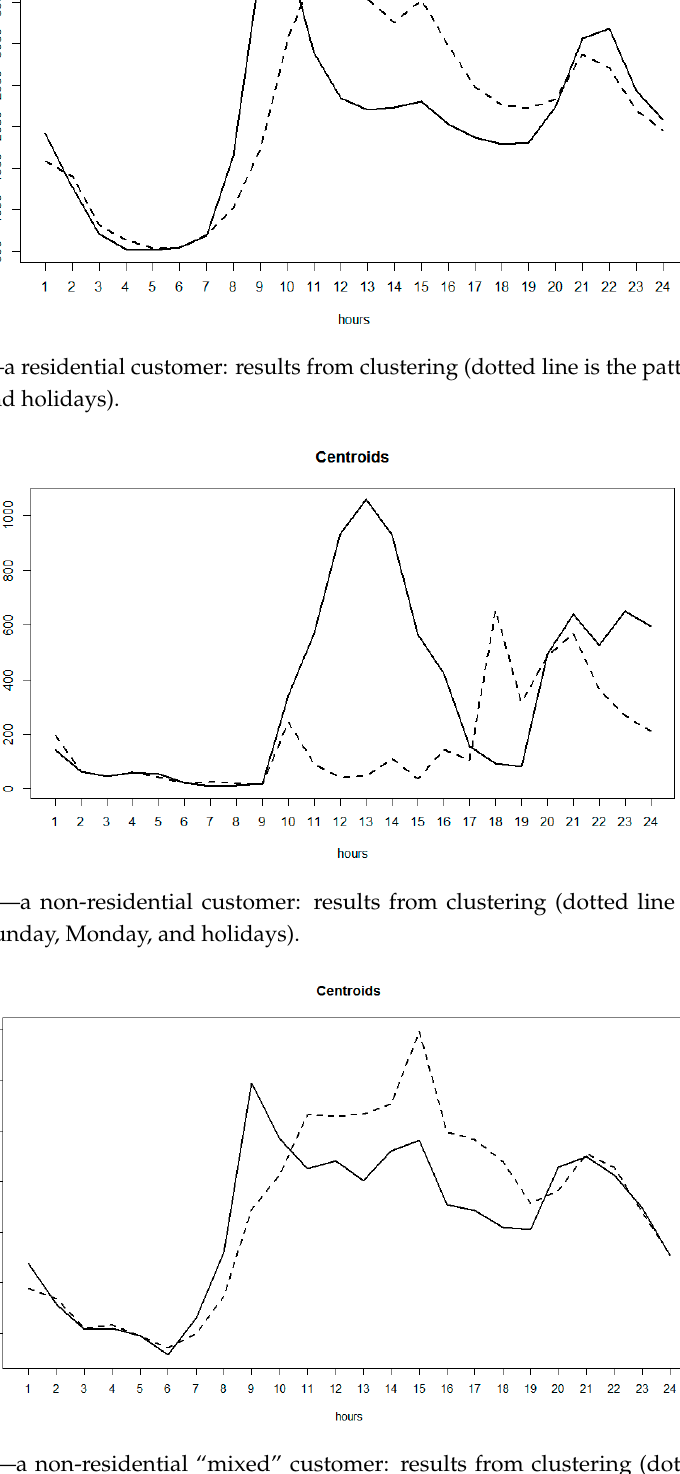
Figure 9. Case 3—a non-residential “mixed” customer: results from clustering (dotted line is the pattern associated with weekends and holidays).